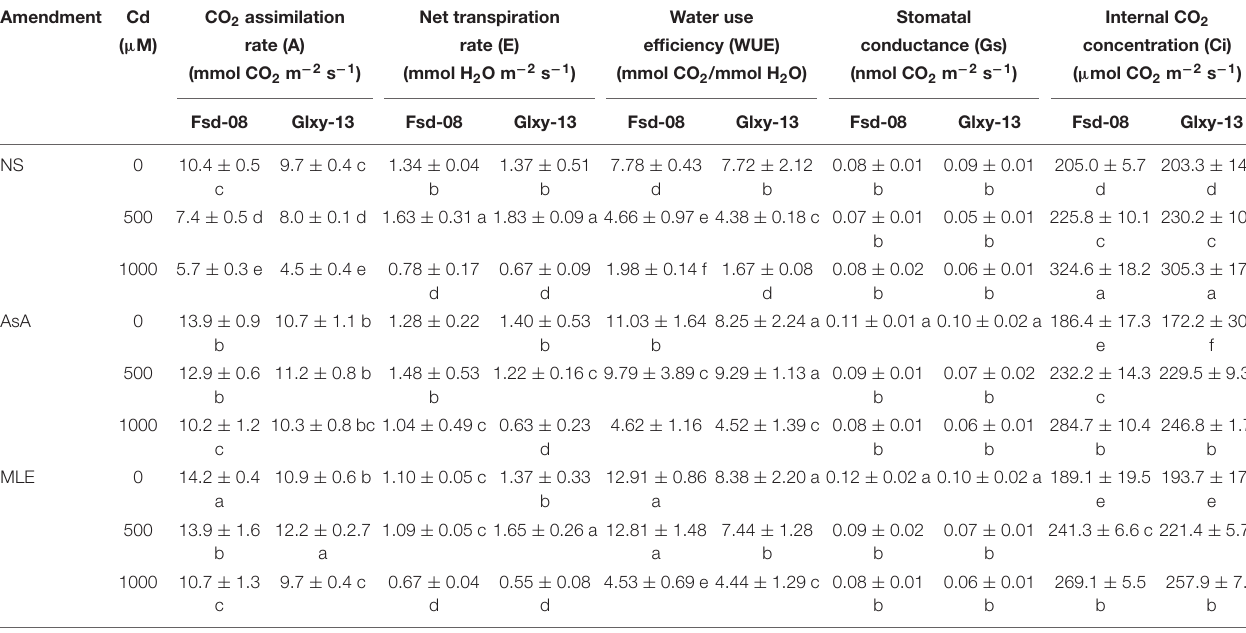
TABLE 2 | Variation among gaseous exchange attributes under the foliar spray of AsA and MLE, along with NS in two wheat cultivars (Fsd-08 and Glxy-13) exposed to the Cd toxicity. Amendment